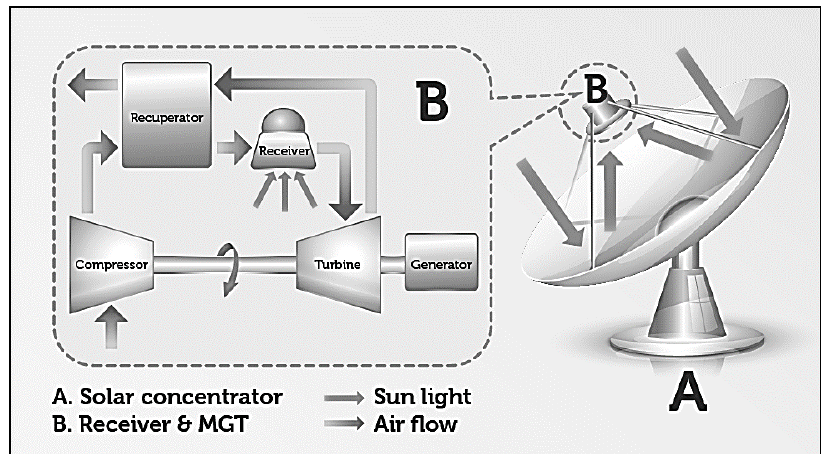
Figure 1. OMSoP solar based MGT system [4].